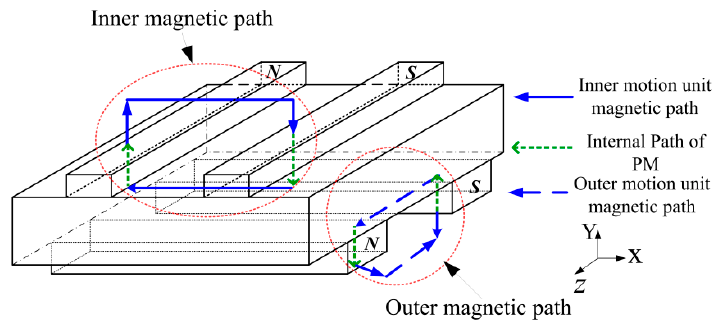
Figure 3. Flux path of the DSLRPMM.